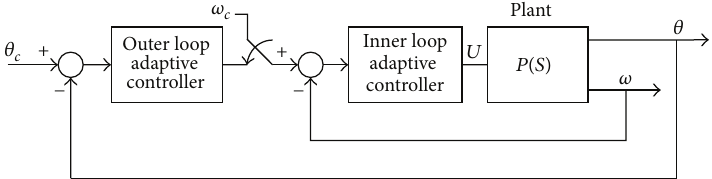
Figure 18: Control configuration of velocity and position servo control system.